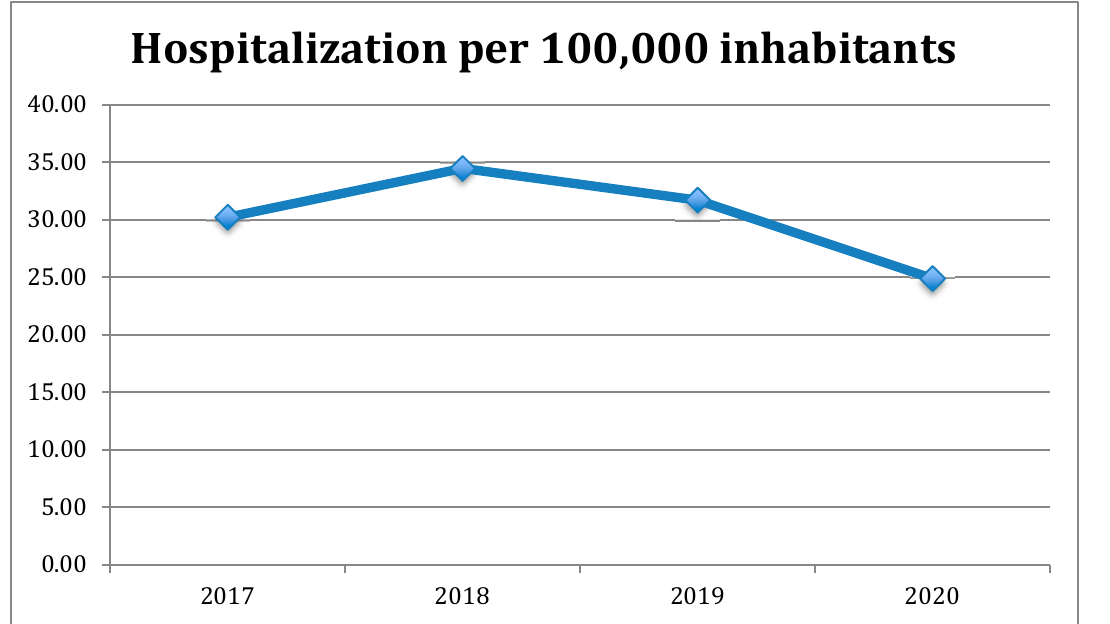
Figure 1. Annual hospitalization for kidney stones in Spain during the period 2017 to 2020. Table 2. Hospitalization rates (rate per 100,000 inhabitants), length of stay (days), mortality (%), and costs (EUR) for kidney stones in Spain (2017–2020) by age.